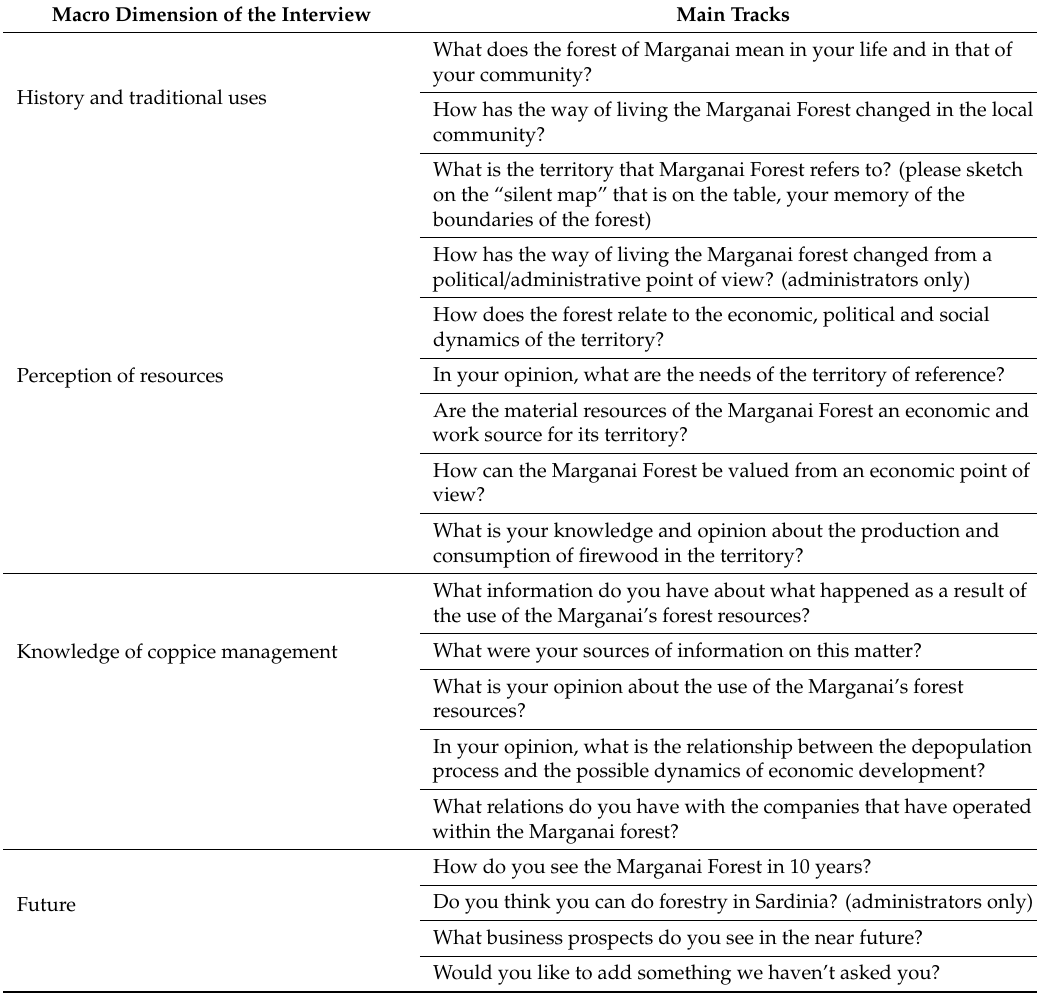
Table 1. Outline of the interviews.